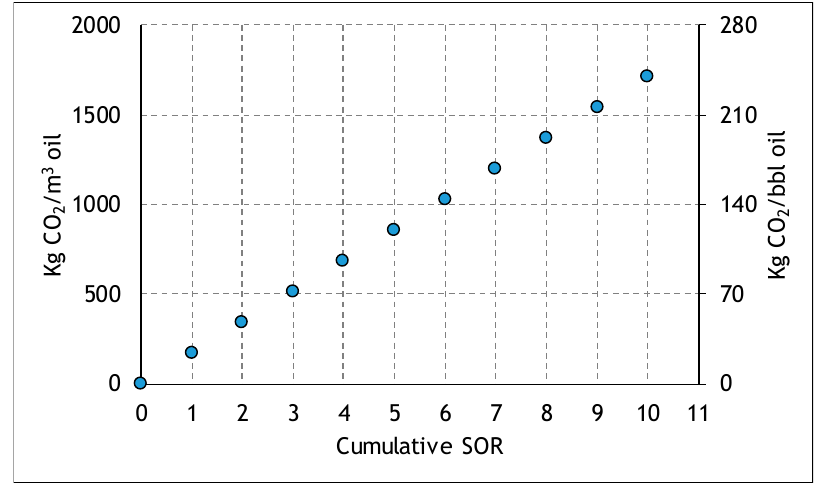
Figure 20. Relation between the mass of carbon dioxide released per volume of oil produced and the cumulative steam-oil ratio.